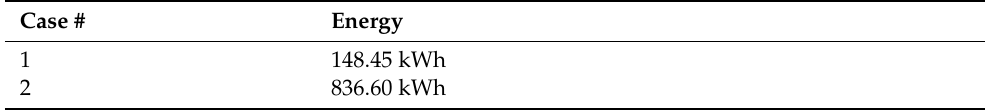
Figure 11. Operation of the different storage facilities in the studied cases. BES (upper) and PHS (middle and bottom). Table 10. Total DEG energy in the studied cases.